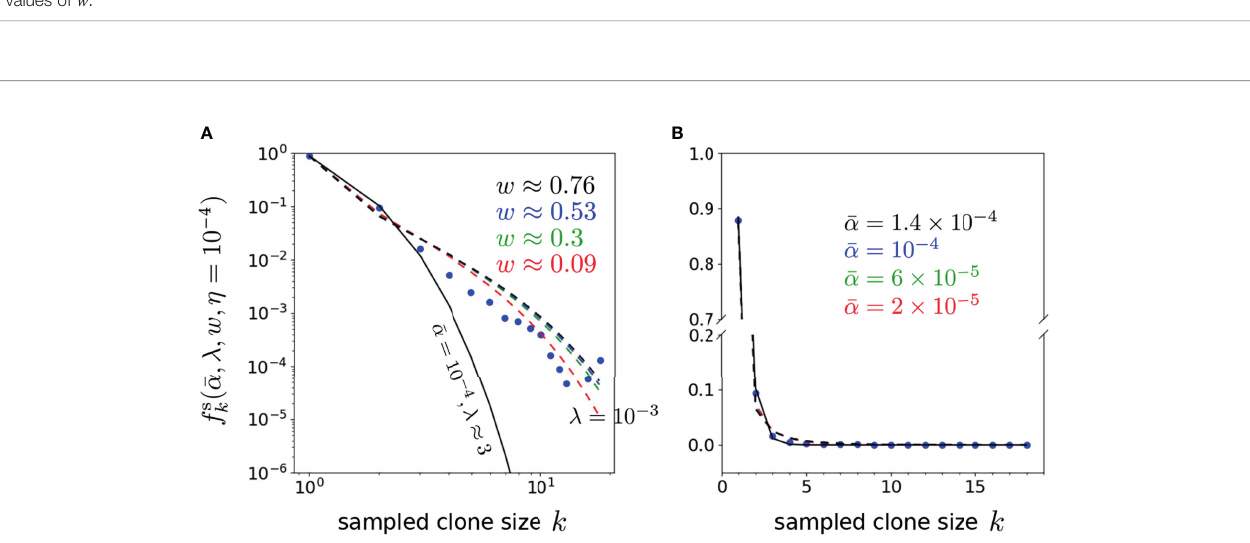
FIGURE 9 | Plots of the representative optimal solutions of clone counts f s k from Eq. 19 (using h = 10 -4 and l = 10 -3 unless otherwise indicated) plotted along side the shown data from Oakes et al. (12). The model predictions and CD4 beta chain data are shown in both (A) log-log and (B) linear scales (there are no zero-values clone counts in this dataset). In (A) , the best fi t model for the neutral model ( w = 0 and p a ( a j (cid:2) a ) = d ( a − (cid:2) a )) using (cid:2) a = 10 (cid:3) 4 is given by l ≈ 3 shown by the solid black curve. The dashed curves represents best- fi t curves using the values associated with the error minima in, where (cid:2) a = 2 (cid:4) 10 (cid:3) 5 , w ≈ 0.09 (red), 6 × 10 -5 , w ≈ 0.3 (green), 10 -4 , w ≈ 0.53 (blue) and 1.4 × 10 -4 , w ≈ 0.76 (black). Note that the neutral model fi ts well for only the fi rst 2-3 k -points, while the heterogeneous model ( w > 0 ) fi ts better at larger k .